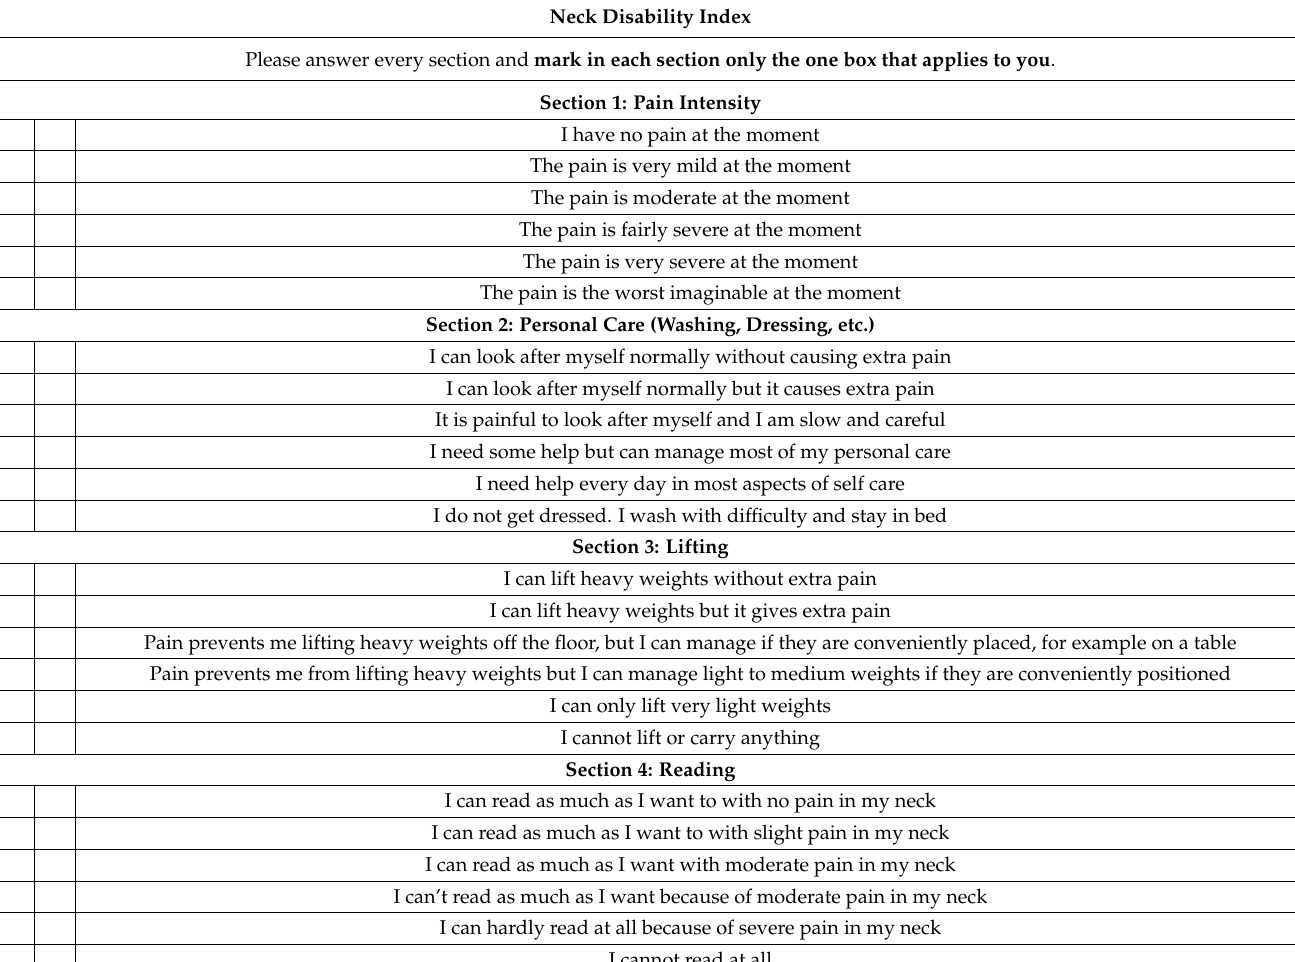
Table A3. Neck Disability Index (NDI)